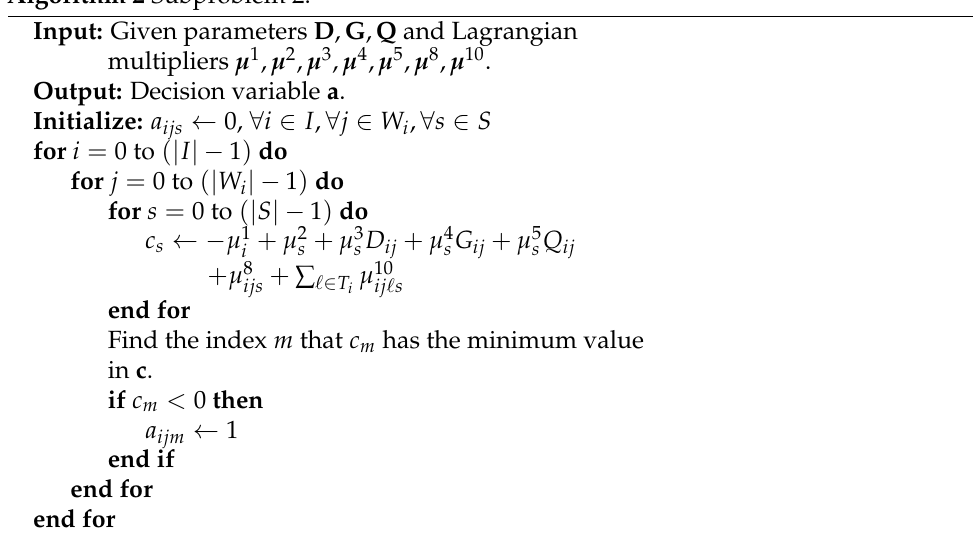
Algorithm 2 Subproblem